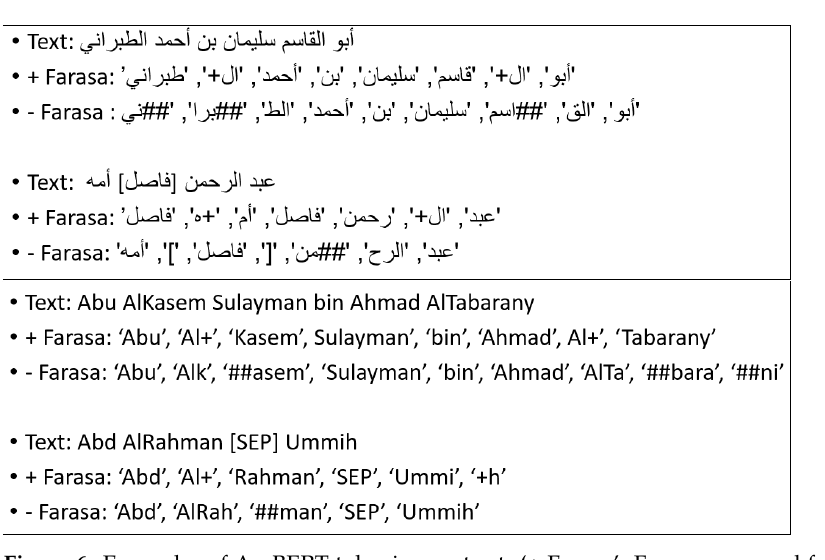
Figure 6. Examples of AraBERT tokenizer output. ‘+ Farasa’: Farasa was used for preprocessing. ‘ − Farasa’: No preprocessing. Out-of-Vocab words are split, and the subwords are marked with ##. At the bottom are transliterations of the given